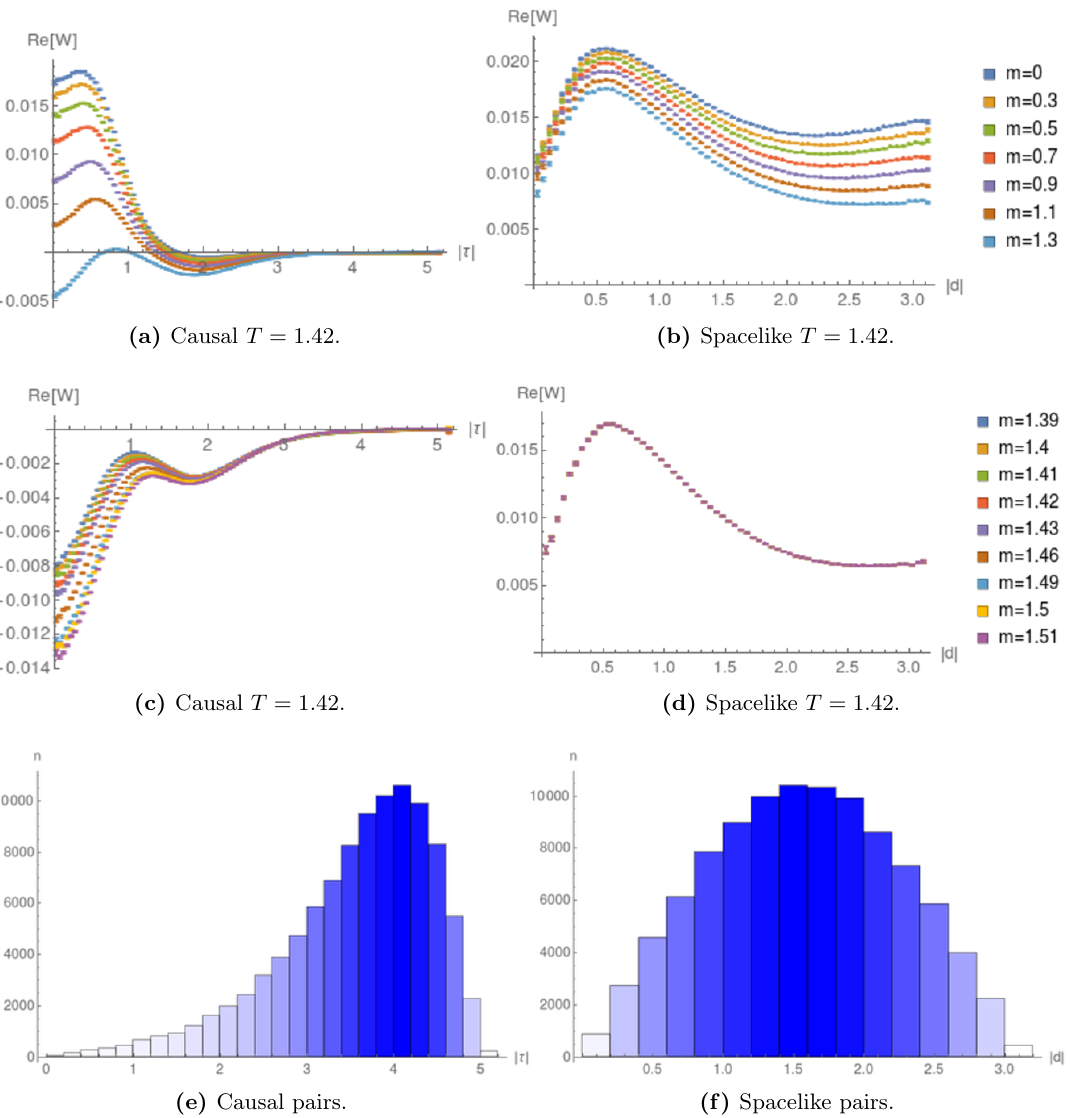
Figure 25. Re[ W ] vs. geodesic distance with varying m at (cid:26) = 9, in 4d de Sitter. (e)-(f) show SJ the distribution of pairs.